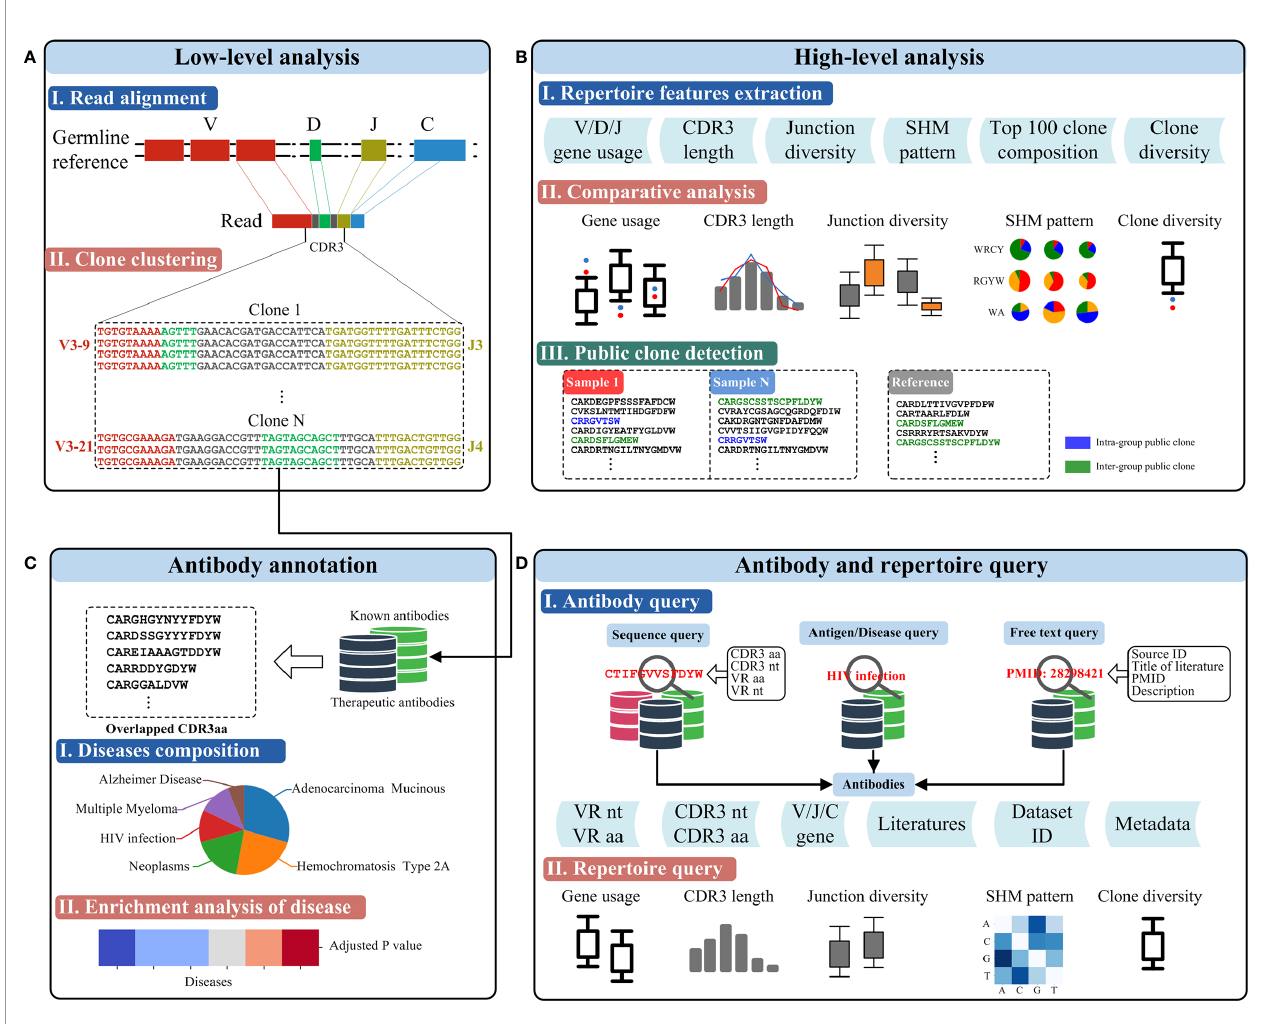
FIGURE 2 | Functionalities of RAPID. (A) Low-level analysis. Germline genes and the antibody sequence derived from the recombination are shown schematically on top. CDR3s were identi fi ed using the RAPID bioinformatics pipeline, and clonalities of antibodies were de fi ned according to sequence similarity and V/J gene segments (bottom). (B) High-level analysis of Rep-seq dataset. Repertoire features were extracted from the Rep-seq datasets (top). The features of the experimental and reference groups were compared and shown (middle). Public clones, if available, were extracted and displayed (bottom). (C) Antibody annotation based on CDR3 aa. Antibodies having the same amino acid CDR3 as known or therapeutic antibodies were extracted and annotated based on their matches in the database (middle). Enrichment of the annotated antibodies were analysed, and a p value was calculated. (D) Antibody and repertoire query function. The top panel shows several antibody queries and the schematics of the result. The bottom panel shows the visualized results of a repertoire